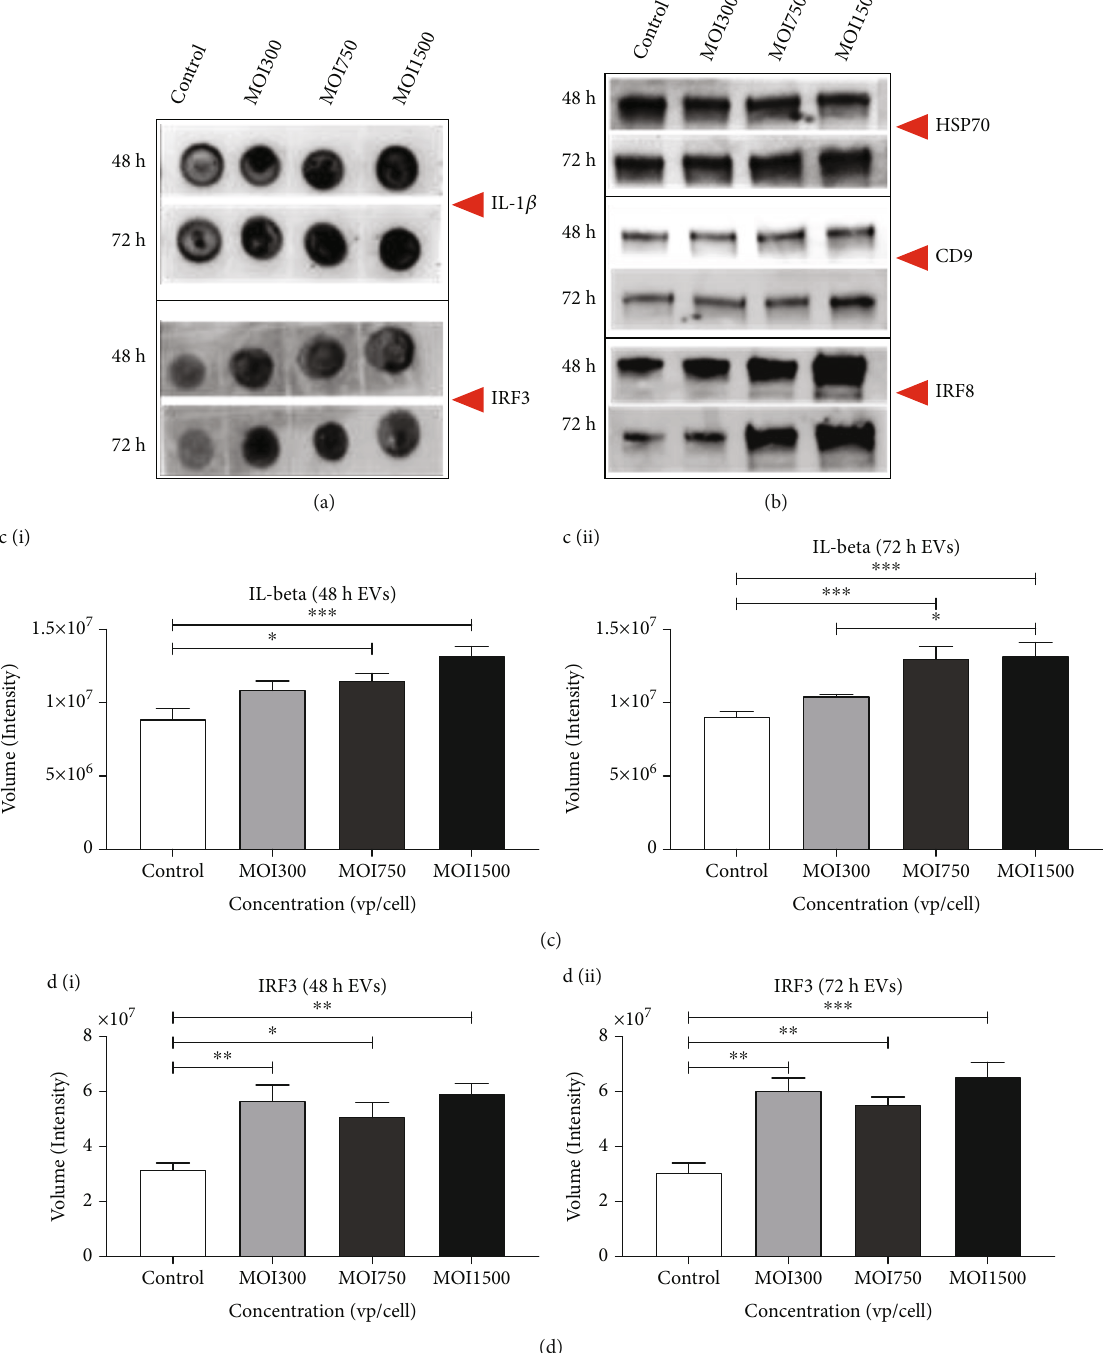
Figure 7: The e ff ect of HAdV3 infection on proin fl ammatory interleukin and interferon. (a) Dot blot analysis showing expression of IL-1 β and TLR7 after 48h and 72 h infection. EVs were probed for the expression of IL-1 β and TLR7 proteins. (b) Western blot analysis showing Hsp70, CD9, and IRF8 expression after 48 h and 72 h of infection. (c) (i) Graph showing quanti fi cation of IL-1 β after 48h and (ii) 72 h of infection. (d) (i) IRF-3 after 48 h and (ii) 72 h of infection. Dots shown in the fi gure are representative of four independent experiments. Data shows the mean ± SEM from four independent experiments and performed using one-way analysis of variance (ANOVA) with Tukey post hoc analysis. Statistical signi fi cance is indicated by the mean ± SD as follows : ∗ p < 0 : 05 , ∗∗ p < 0 : 01 , ∗∗∗ p < 0 : 001 , and ∗∗∗∗ p < 0 : 0001